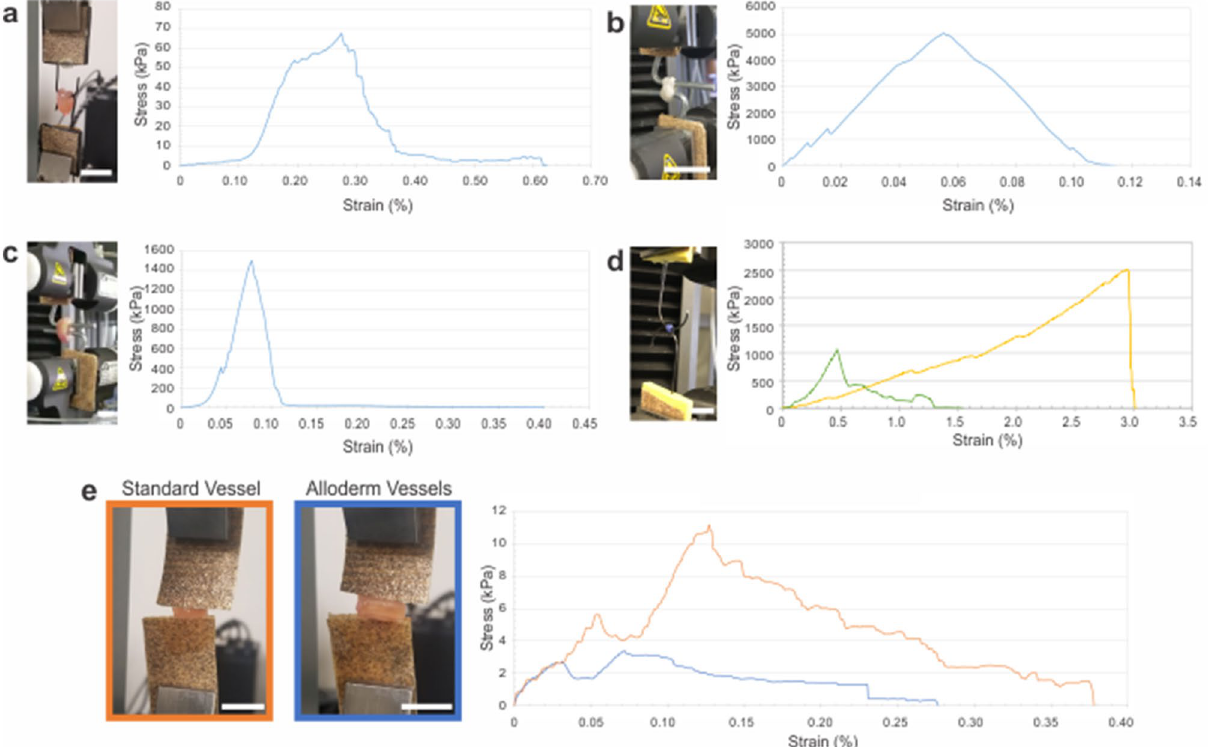
Figure 3. Significantly increased mechanical properties with inclusion of Alloderm into engineered vascular vessels. Average circumferential stress–strain curves for ( a ) standard vessels (n = 5), ( b ) Alloderm alone (n = 4), ( c ) Alloderm vessels (n = 5), and ( d ) human diabetic saphenous veins (green line; n = 6) and cadaver femoral arteries (yellow line; n = 8). ( e ) Average longitudinal stress–strain curves for standard and alloderm vessels; average circumferential stress–strain curves. Scale bars = 1 cm.